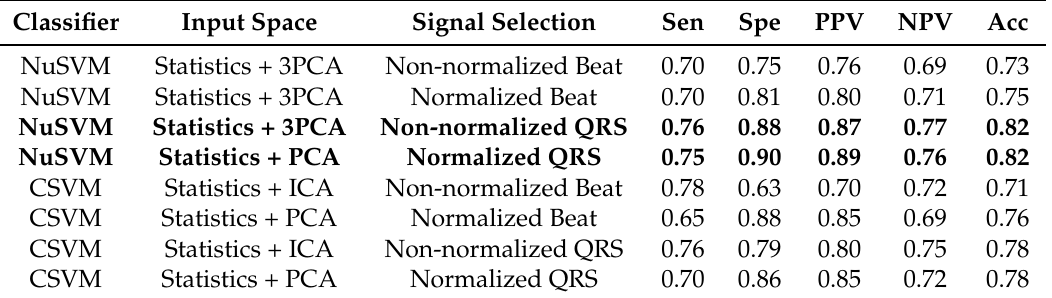
Table 1. Summary of linear classifiers over SWfrag-DB.